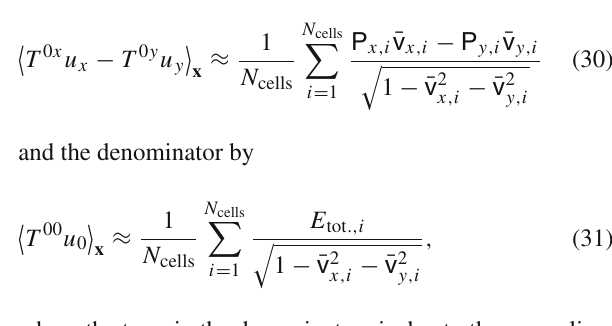
the total energy E tot . , the number of particles, and the mean velocity per particle ¯ v x ≡ P x / E tot . and ¯ v y ≡ P y / E tot . . Then we can approximate the numerator of Eq. (27)